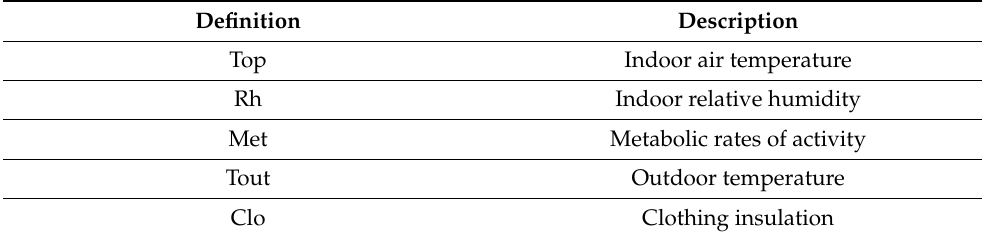
Table 1. The Factors of PMV Inference Model.